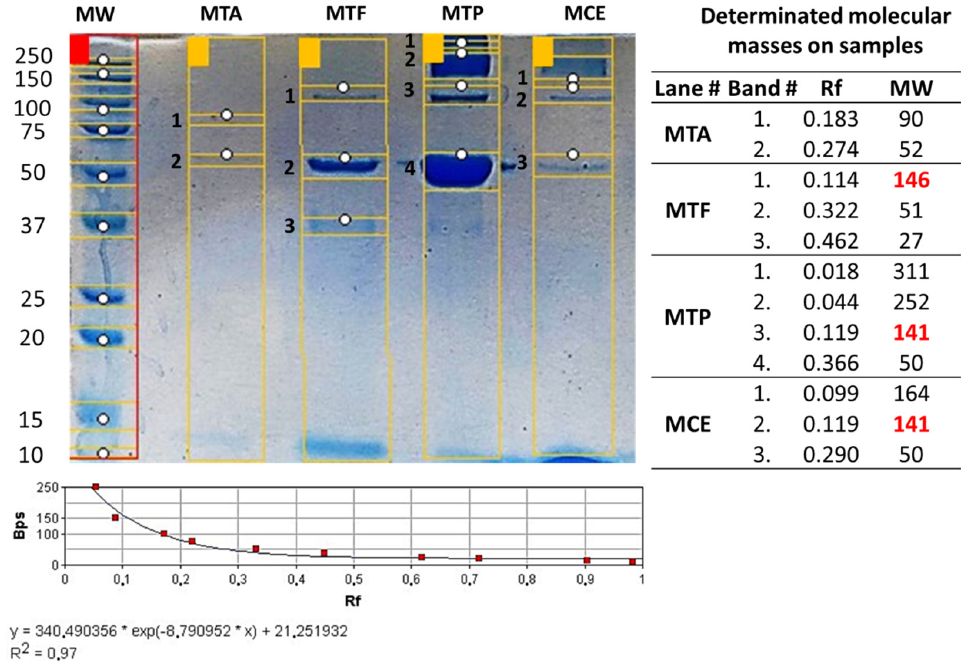
Figure 8. Monovalent batches electrophoresis. Ten percent TRIS-TRICINE gels loading 1.5 mg/mL of purified IgG after tangential flow filtration (final product). M.W.: Molecular weight. Calibration curve using an exponential fit approximation to determine molecular masses on each purified IgG batch. Red highlighted molecular weights indicate bands matching molecular masses of IgG. M.T.A.: Tityus asthenes monovalent batch; M.T.F.: Tityus fuhrmanni monovalent batch; MTP: Tityus pachyurus monovalent batch; M.C.E.: Centruroides spp. monovalent